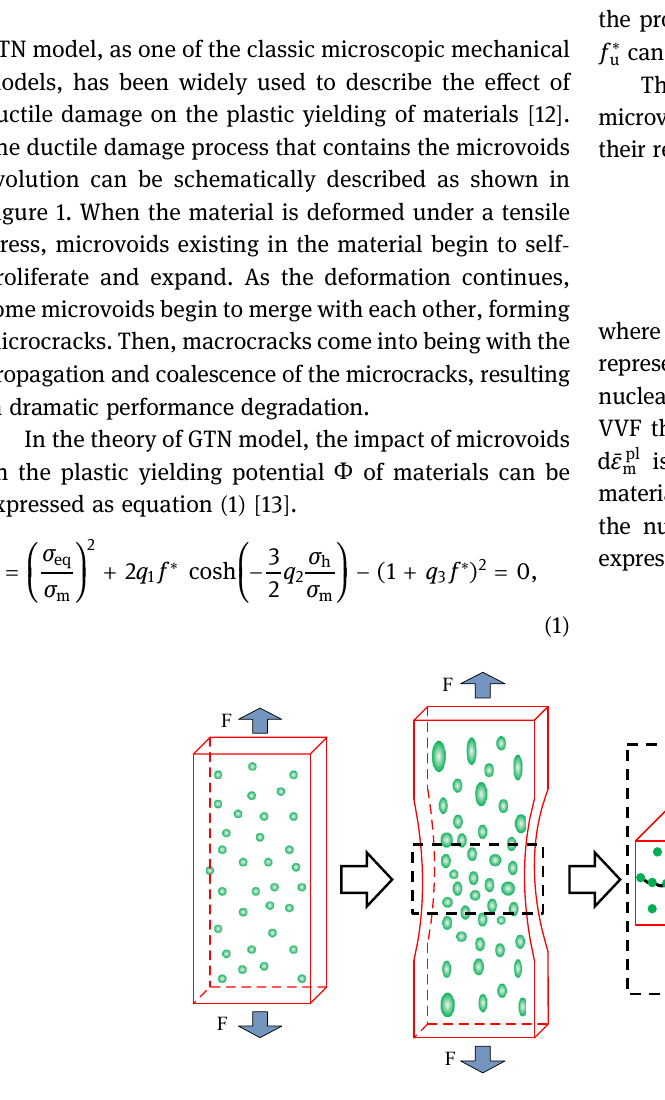
Figure 1: Schematic illustration of ductile damage